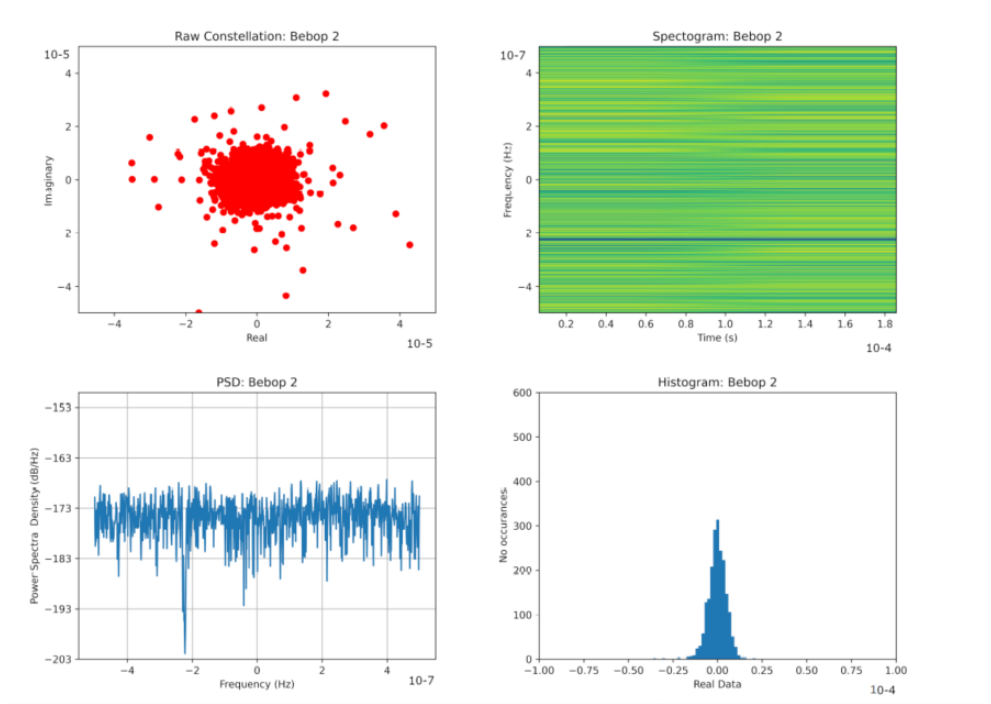
Figure 5. Bebop Mode